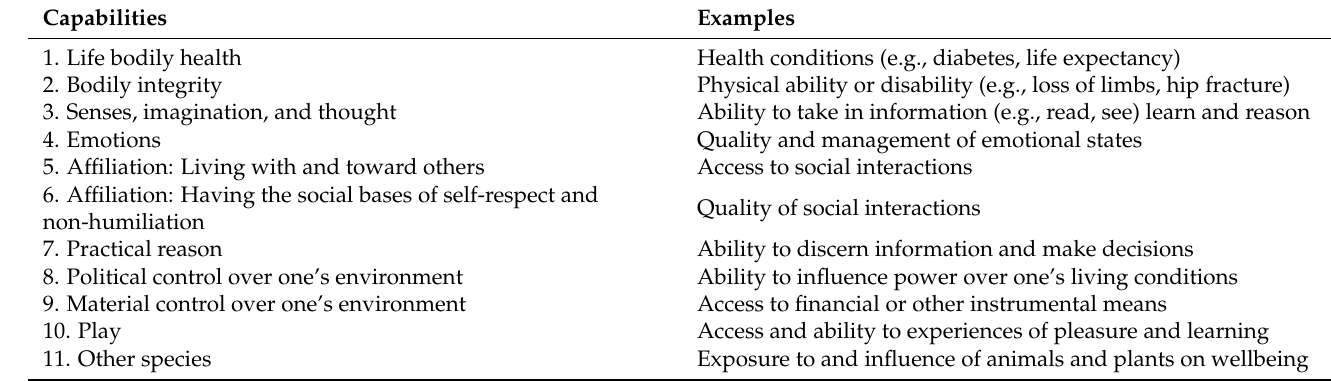
Table 1. Central human functional capabilities